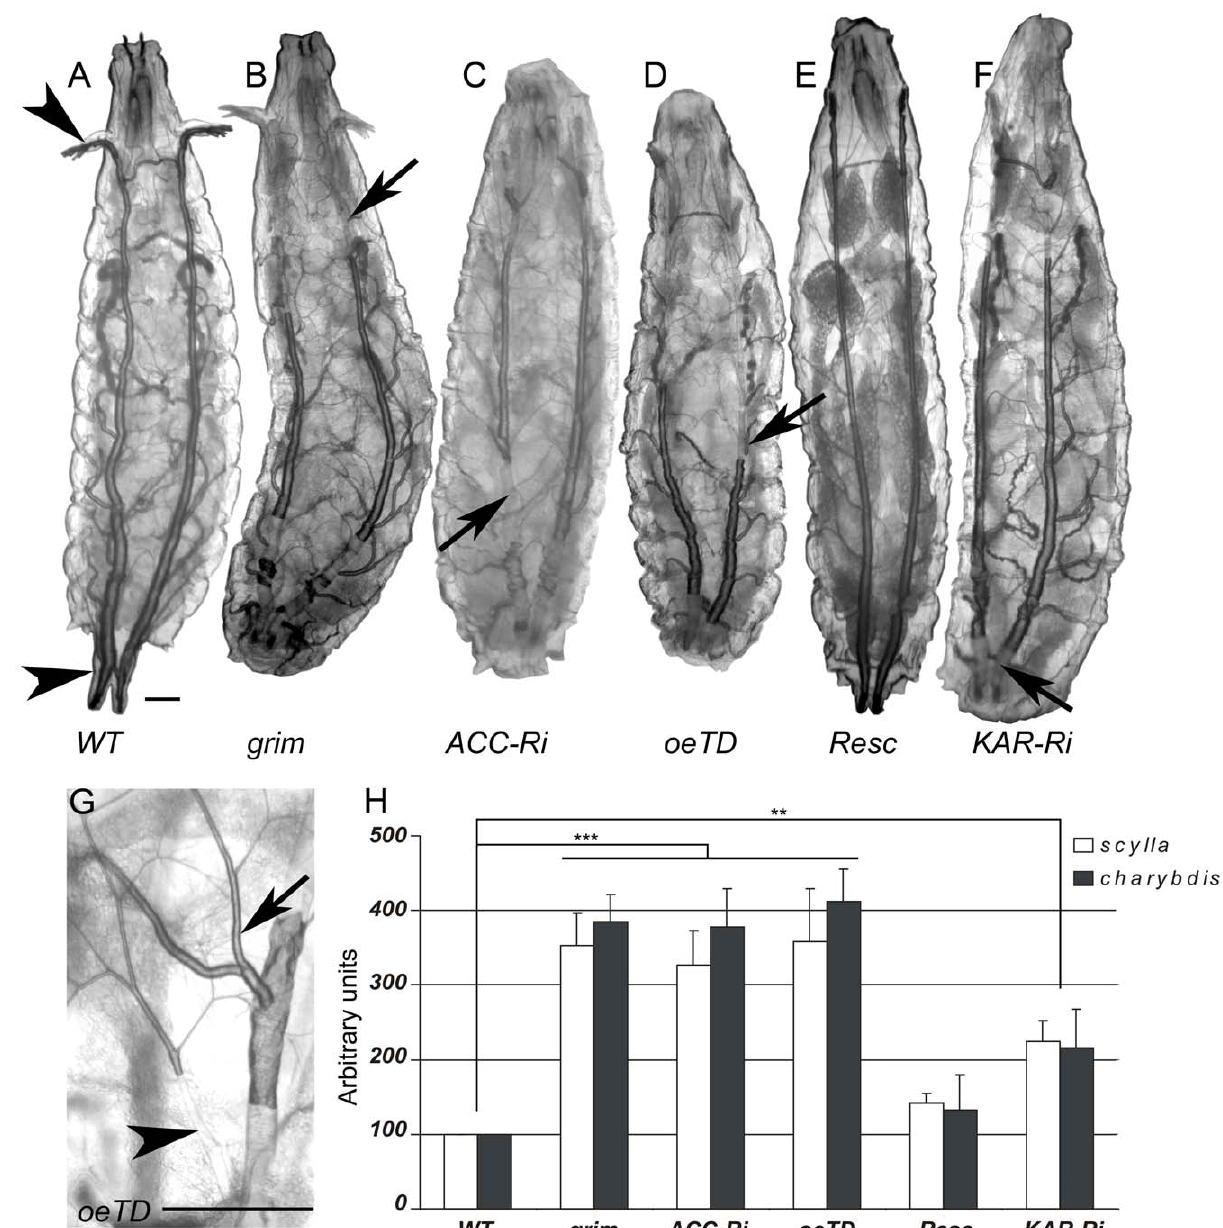
Figure 4. Oenocytes ACC signals to the tracheal system. (A) Dorsal view of a wild-type larva showing the two dorsal main trunks of the tracheal system, which extend from the anterior to the posterior spiracles (arrowheads). Air-filling phenotypes in the tracheal systems of BO . grim (B), BO . ACC-RNAi (C), ACC oeTD mutant (D), ACC B131 mutant rescued by ubiquitous UAS-ACC (E) and BO . KAR-RNAi (F) animals. The portions of the dorsal main trunks filled with an aqueous solution are difficult to distinguish (arrows). The larvae have been selected early after the L2/L3 molting transition (prior to death in B,C,D,F). Larvae oriented anterior to the top. (G) Higher magnification of tracheal branches in early L3 ACC oeTD larvae; a branch that originates from the air-filled part of the main trunk is entirely filled with air (arrow) whereas a branch that originates from the liquid-filled part of the main trunk is filled with liquid in its proximal end but not in the distal sub-branches (arrowhead). Scale bars: 100 m m. (H) Transcriptional expression of the charybdis and scylla hypoxic-responsive genes in control, cell-ablated, ACC or KAR deficient animals. Symbols used: ( WT ) control; ( grim ) BO . grim ; ( ACC-Ri ) BO . ACC-RNAi ; ( oeTD ) ACC oeTD ; ( Resc ) ACC B131 ;da-Gal4 . UAS-ACC ; ( KAR-Ri ) BO-Gal4 . KAR-RNAi . Genotypes behaved differently in their hypoxic response (ANOVA: genotype: F5,32=36.19 P , 10 2 3 ; gene F1,32=1.24 P=0.27; genotype 6 gene: F5,32=0.47 P=0.795). Dunnet T test: *: P , 0.05; **: P , 0.01; ***: P , 0.001. doi:10.1371/journal.pgen.1002925.g004 modified in mid L1 larvae with the BO . ACC-RNAi and BO . grim observed in ACC oeTD larvae but not in ACC B131 mutant larvae genotypes (Figure S7). In contrast, charybdis and scylla were rescued by ubiquitous expression of UAS-ACC (Figure 4G). dramatically induced in larvae at the L2/L3 transition Consistent with the semi-lethal phenotype, charybdis and scylla (Figure 4H). Similarly, high expression levels of both genes were were also induced in BO . KAR-RNAi larvae at the L2/L3